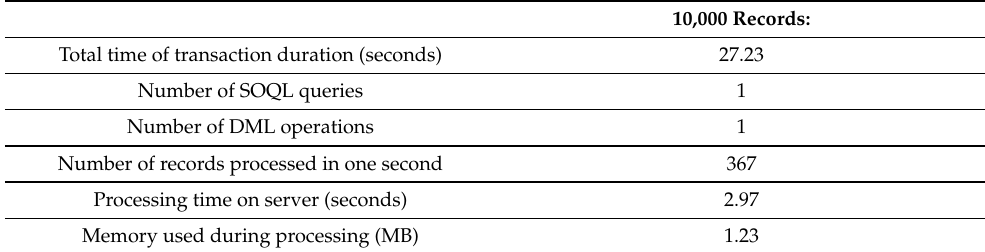
Table 6. Future Apex processing results for update